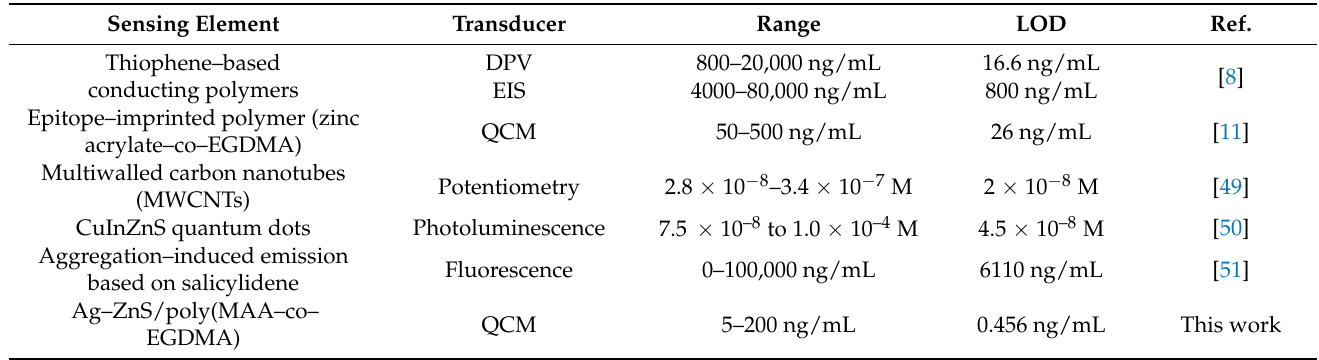
Table 2. A comparison of Ag-ZnS@MIP-based HSA sensor performance with different HSA sensing methods from the literature.